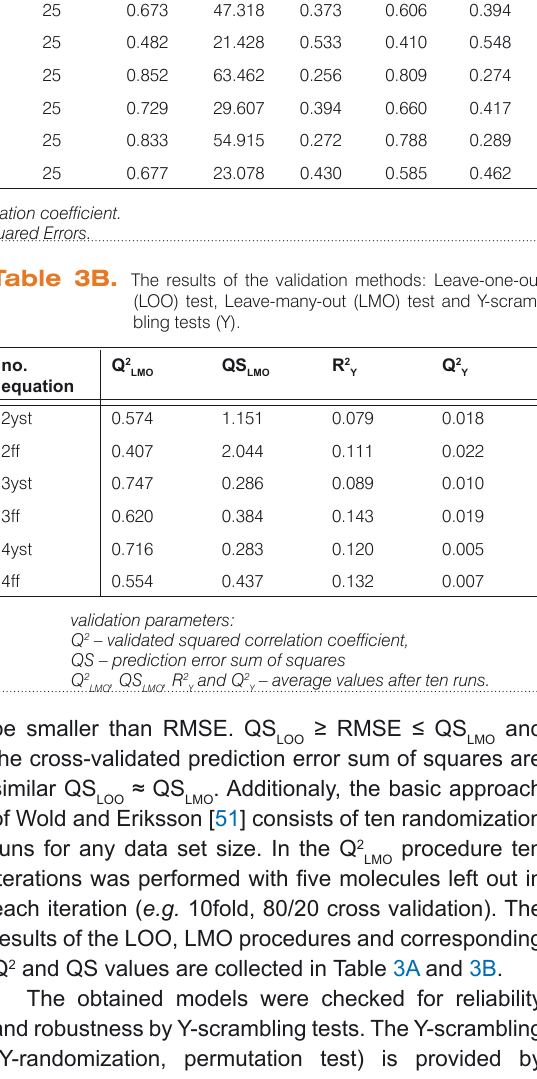
Table 3A. QSAR equations with the best fits to the experimental data.